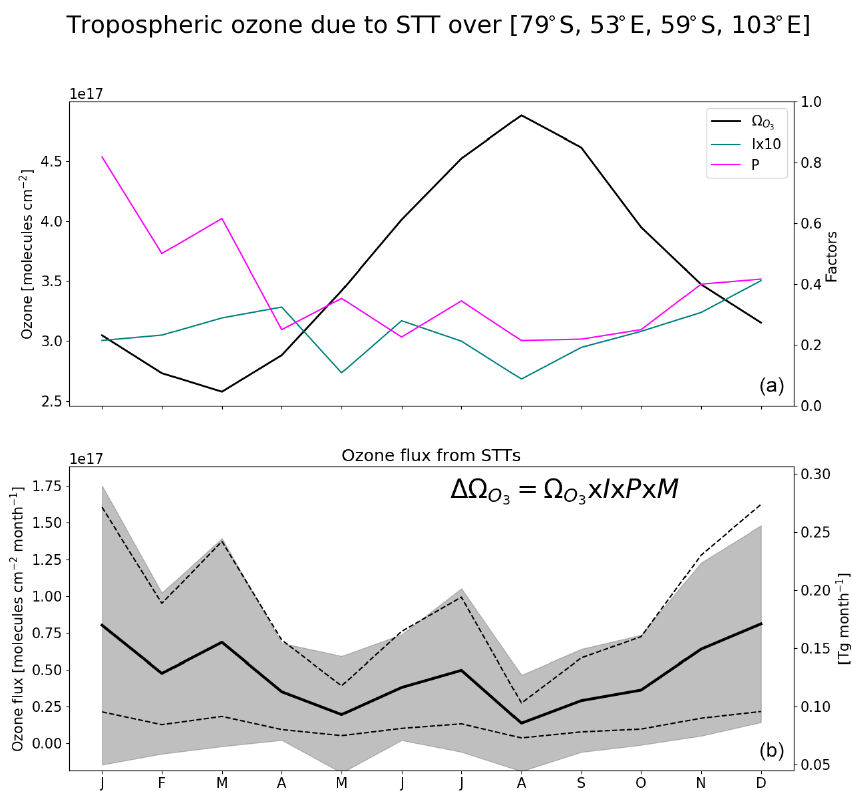
Figure 13. (a) Tropospheric ozone, impact per event, and probability of event detection per sonde launch, averaged over the region above Davis. The tropospheric ozone column (cid:127) O (black, left axis) is from GEOS-Chem, while the STT probability P (magenta, right axis) and 3 impact I (teal, right axis) are from the ozonesonde measurements. The STT impact is multiplied by 10 to better show the seasonality. (b) Estimated contribution of STT to tropospheric ozone columns over the region, with uncertainty (shaded area) estimated as outlined in Sect. 6. The black line shows STT ozone flux if event lifetime is assumed to be 2 days, with dashed lines showing the range of flux estimation if we assumed events lasted from 1 day to 1